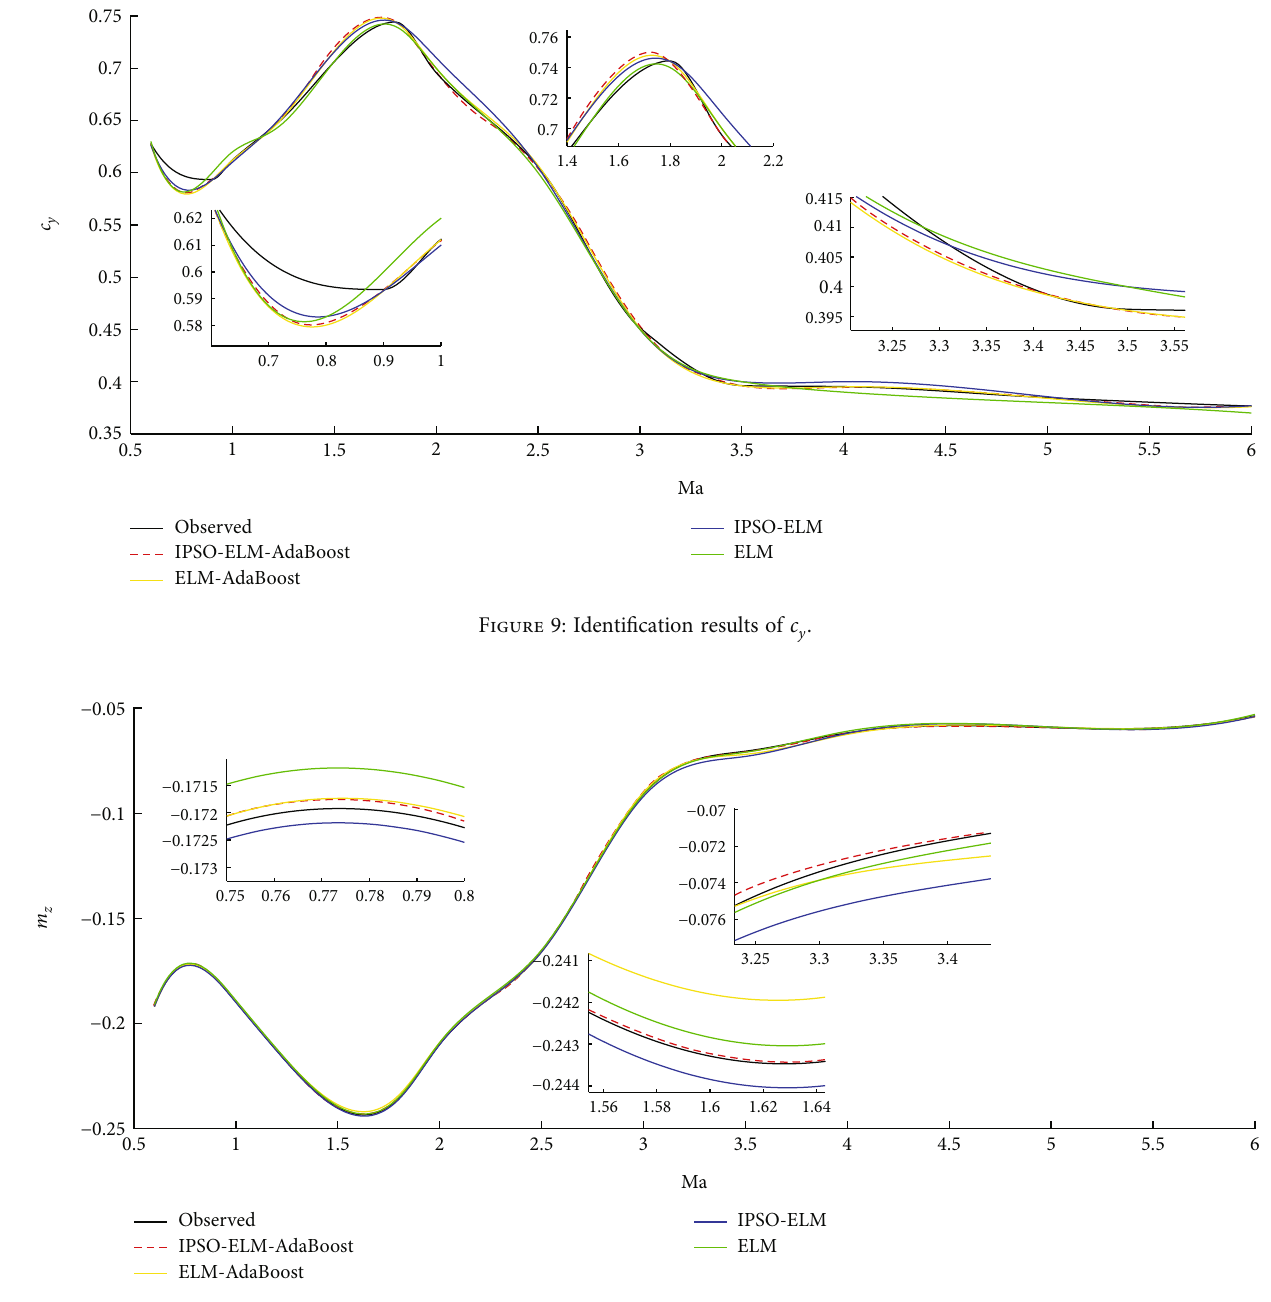
Figure 10: Identi fi cation results of m